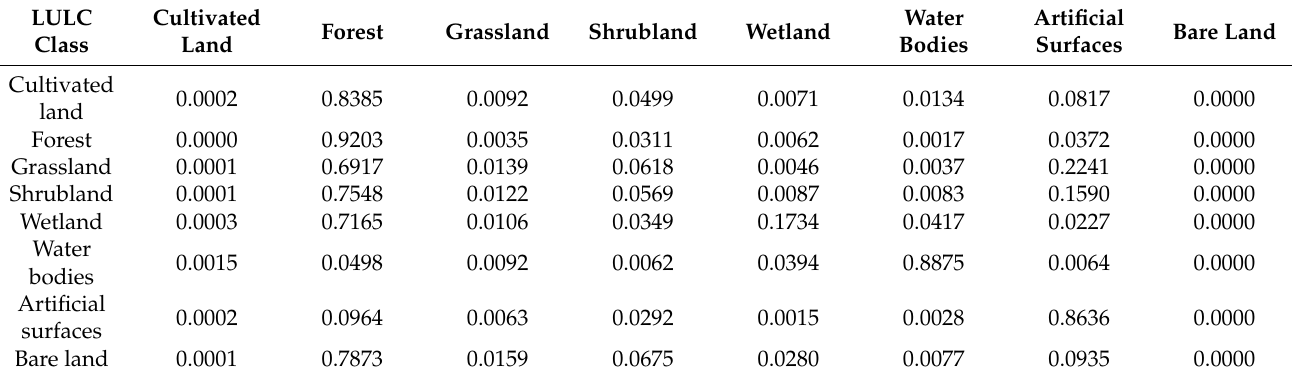
Table 6. Markov transition probability matrix and LULC change for 2030.